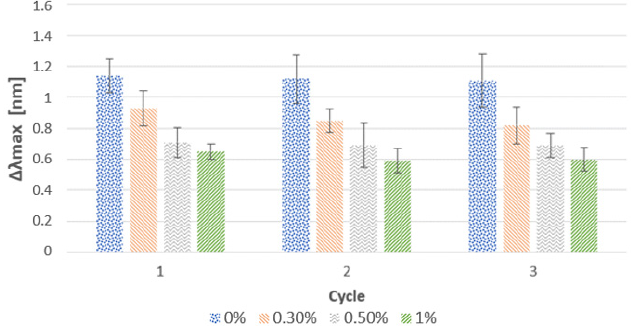
Figure 7. Δλ maximum for samples formulated with SLES/CAPB 12 wt. %, cationic polymer 0.5 Figure 7. ∆ λ maximum for samples formulated with SLES/CAPB 12 wt. %, cationic polymer 0.5 wt. %, wt. %, and different levels of salt at room temperature and pH ~7. and different levels of salt at room temperature and pH